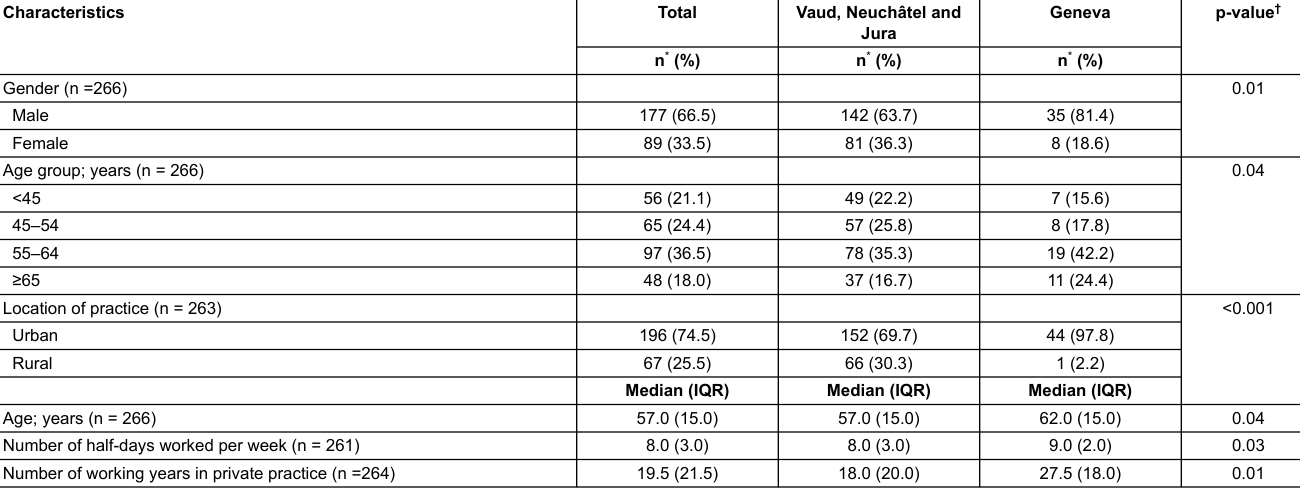
Table 2: Physicians’ sociodemographic characteristics, overall and stratified by canton of practice (Vaud, Neuchâtel and Jura compared with Geneva) (n = 268).